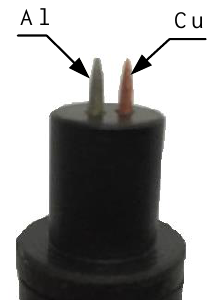
Figure 3. Schematic diagram of fruit battery circuit with charging concept.